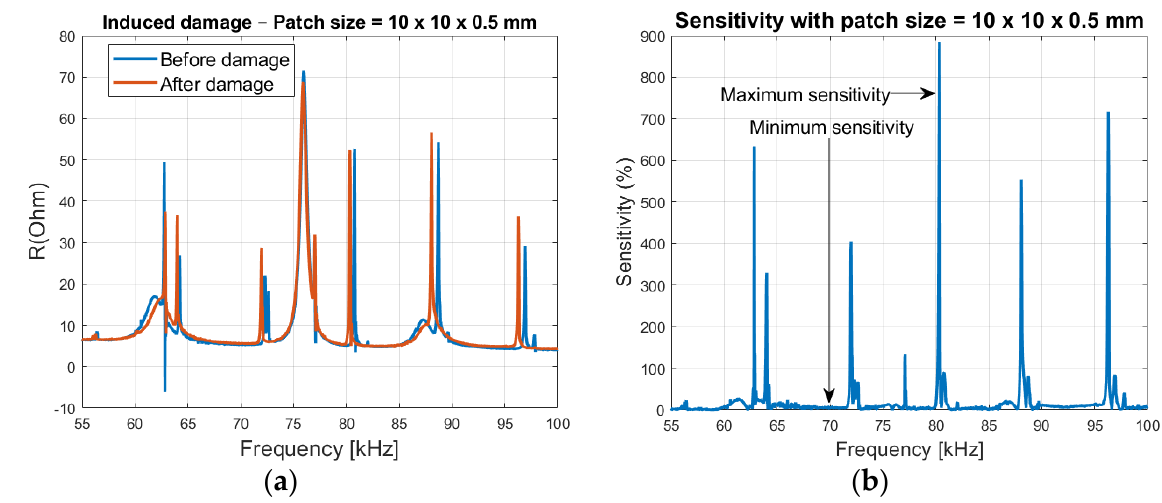
Figure 11. ( a ) Before and after damage on the steel rod, real part of the impedance signature (steel size = 20 × 16 mm and patch size = 10 × 10 × 0.5 mm) and ( b ) Sensitivity plot as a function of frequency.